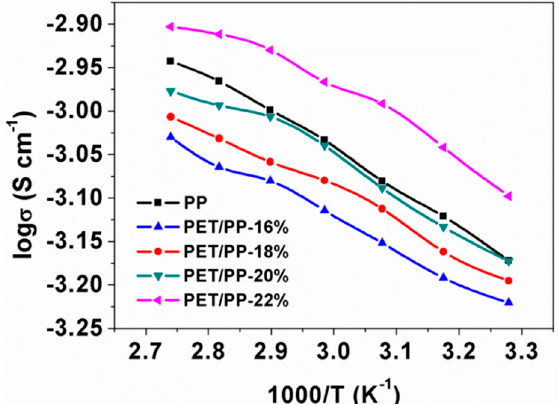
Figure 5. Temperature dependence of ionic conductivity of PP separator and the PET/PP separators.